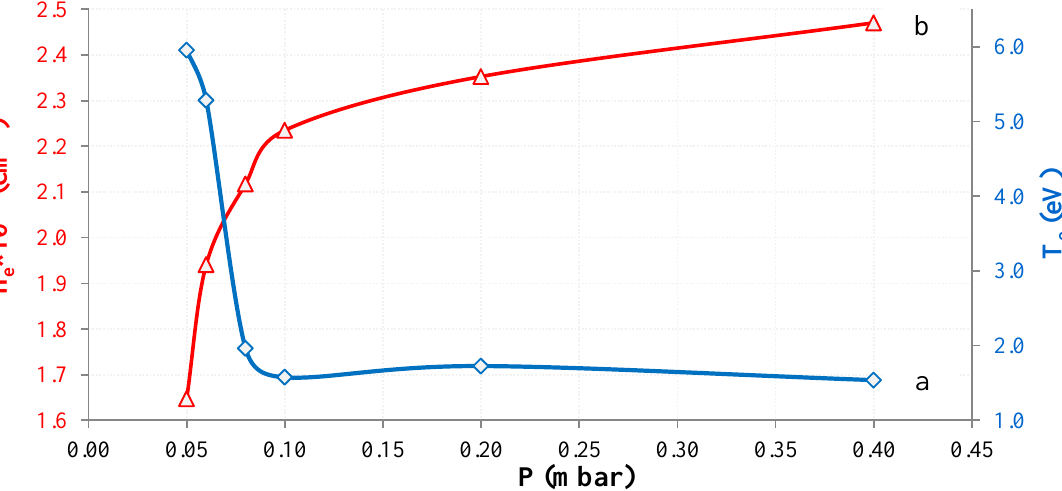
Fig. 4: The variation of (a) T